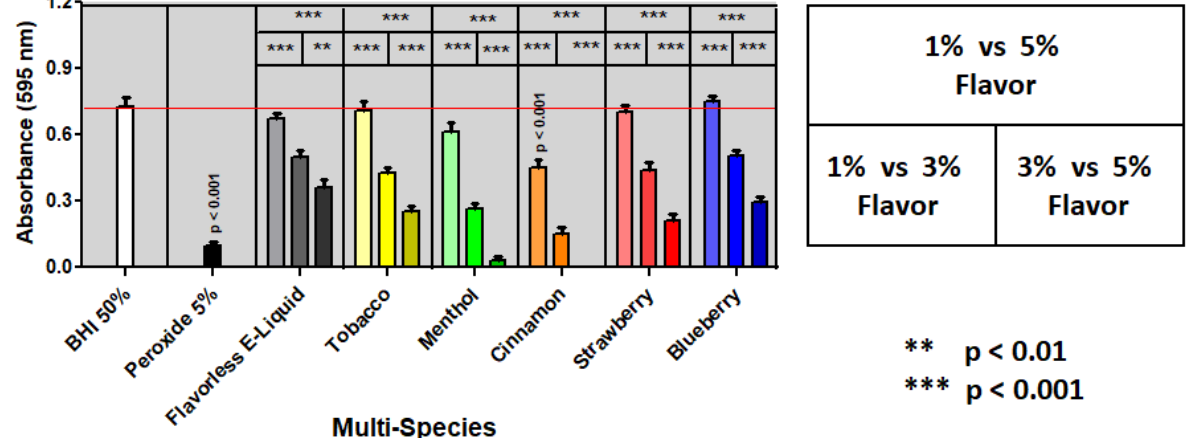
Figure 2. Dose-Dependent effect of E-liquids on Multi-Species ( S. gordonii , S. intermedius , S. mitis and S. oralis ) Biofilm Formation. Mixed streptococci (1:1:1:1) biofilms biomass after treatment with 1, 3, and 5% E-liquids ± flavorings in 50% BHI. The given p values indicate significance between BHI 50% (positive control) and 5% peroxide (negative control) or BHI 50% and 1% E-liquid ± flavors using One-Way Anova. The red line indicates the average absorbance of the positive control. The three boxes above each E-liquid ± flavors indicate significance between them using Two-Way Anova. Each bar represents mean ± SE of absorbance ( n = 12 to